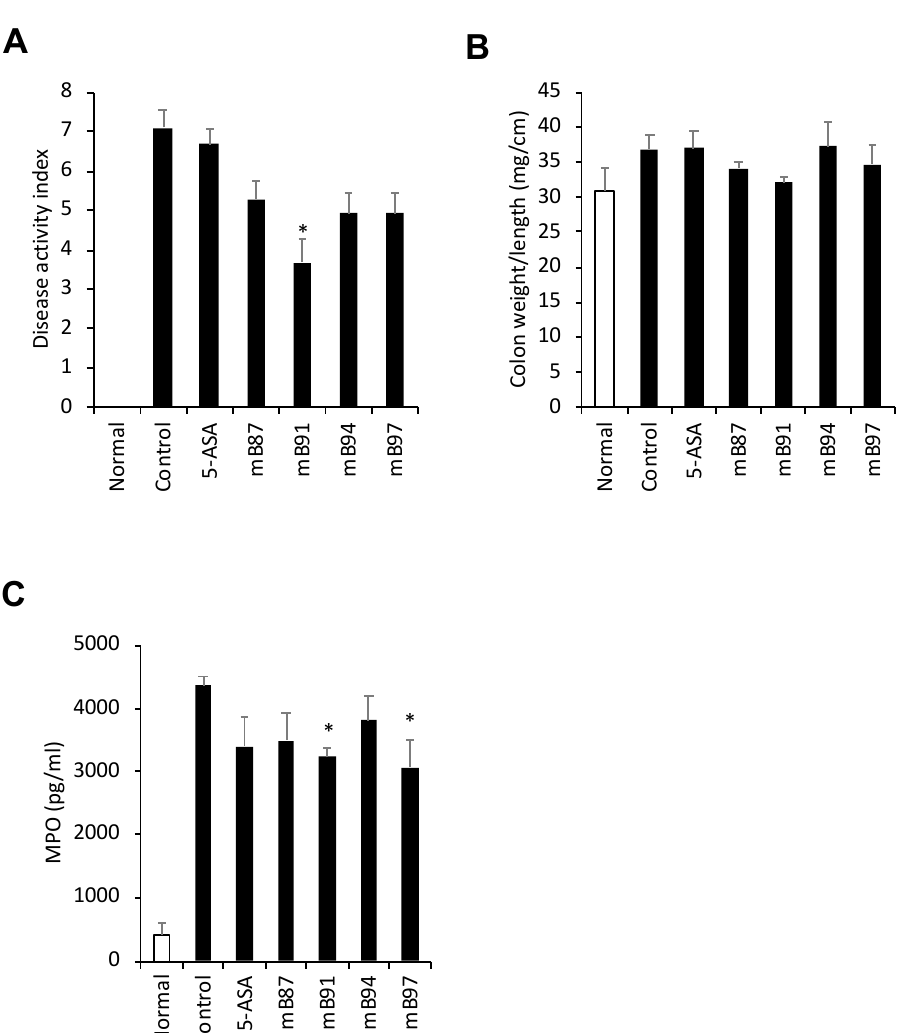
Figure 3. Effect of four selected samples on TNBS-induced colitis in mice. Colitis was induced in ICR mice by the intrarectal injection of TNBS. The animals were treated with extract samples (200 mg/kg) or 5-ASA (200 mg/kg), used as the reference drug, once per day. Disease activity index was scored during the experiment ( A ). Colon weight and length were measured at necropsy ( B ). MPO in the colon tissue lysate was measured by using an ELISA kit ( C ). The data are presented as the mean ± SEM. n = 6–8, * p < 0.05 vs. control.